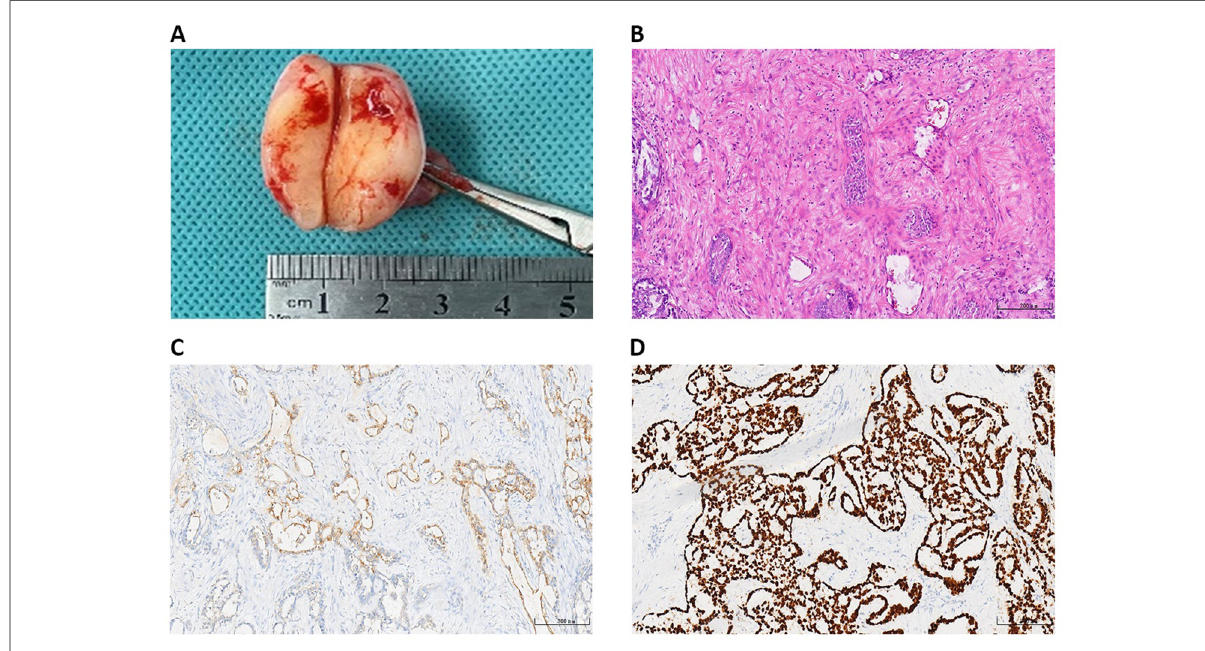
FIGURE 2 The postoperative pathology results. ( A ) Right testicular malignancy without capsular invasion. The results of postoperative pathology with HE staining ( B ) and AFP (+) ( C ), and SALL4 (+) ( D ) in IHC staining of testicular YST. AFP, α -fetoprotein; SALL4, spalt like transcription factor 4; IHC, immunohistochemistry; YST, yolk sac